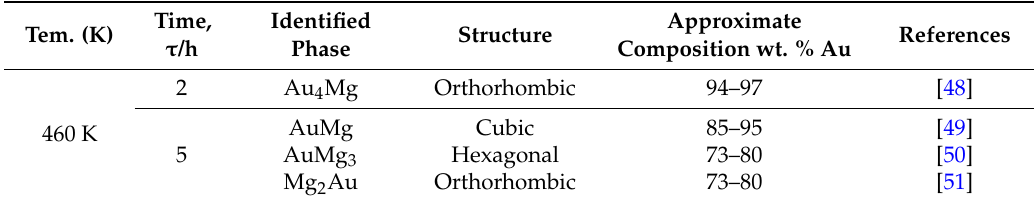
Table 2. The alloys identified on gold samples after magnesium deposition at 460 K and different deposition times in nonaqueous magnesium/ammonium eutectic mixture. Tem.